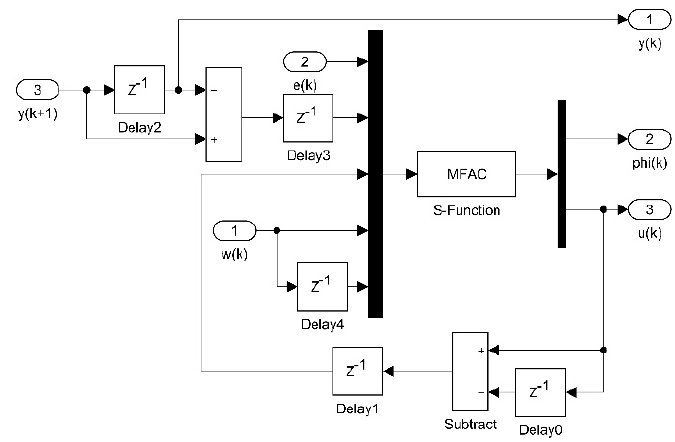
Figure 10. Kernel of the RBFNN-MFAC Controller.